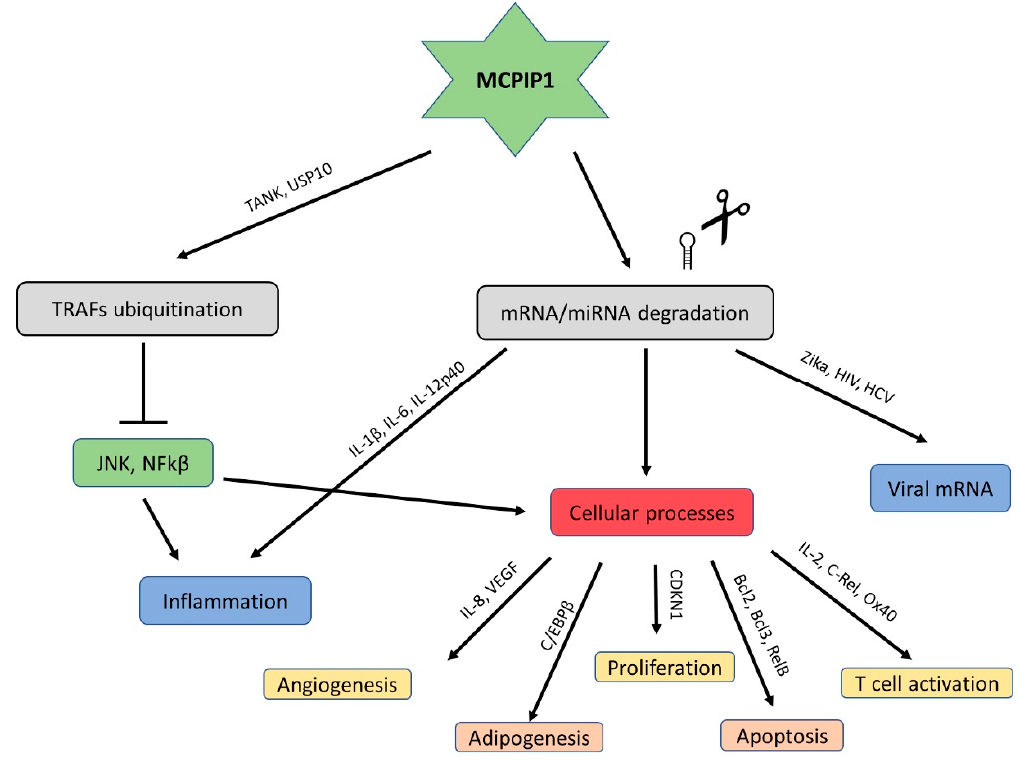
Figure 3. Schematic modes of action of MCPIP1.